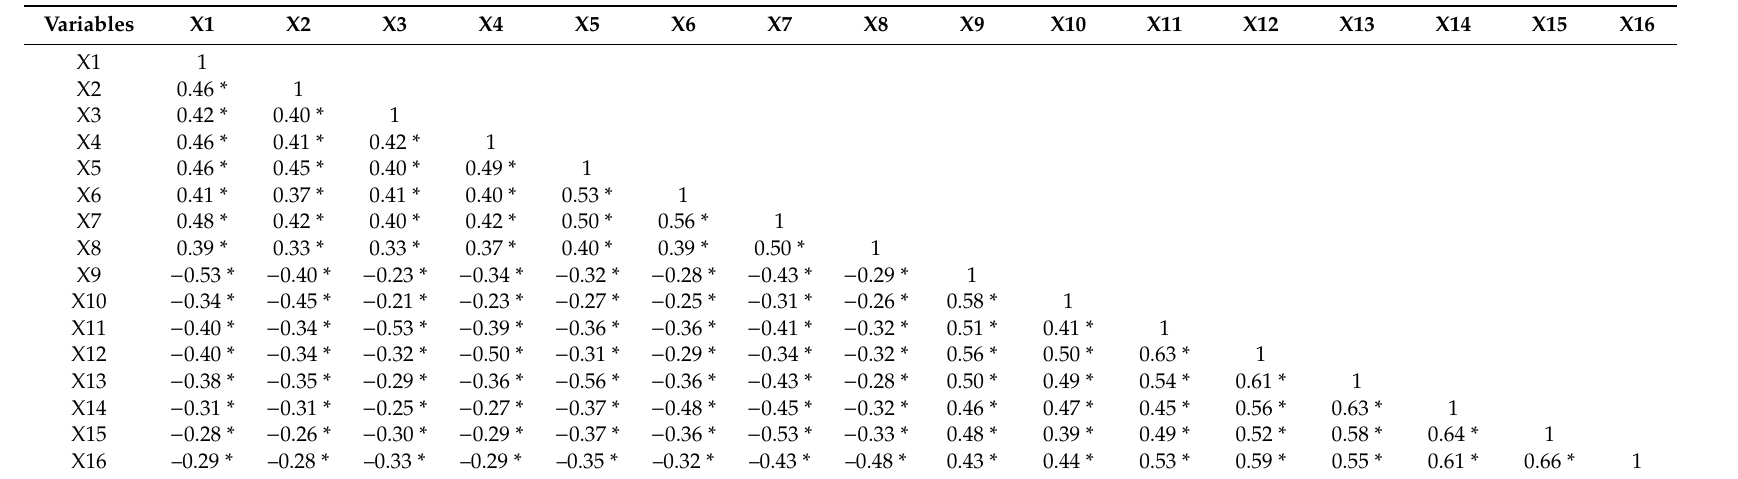
Table 3. Correlation between depression and